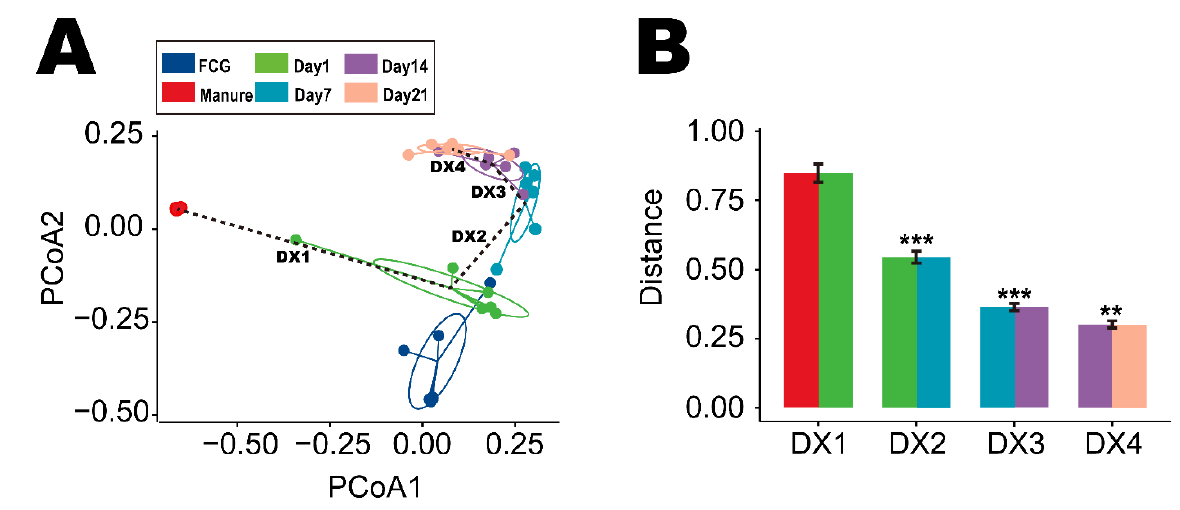
Figure 3. Bray–Curtis distances among groups. ( A ) Projection displayed by principal coordinates analysis (PCoA) based on Bray–Curtis distances represents the shift of microbial composition over time. The dotted line links the time points. ( B ) Comparison of distances of cow manure up to day 1 (DX1), day 1 to day 7 (DX2), day 7 to day 14 (DX3), and day 14 to day 21 (DX4). To track the significance of these distances, the Wilcoxon signed-rank test was applied. ** p < 0.01 and *** p < 0.001.